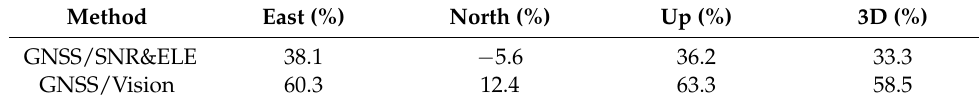
Table 3. Improvements in positioning accuracy expressed as percentages.